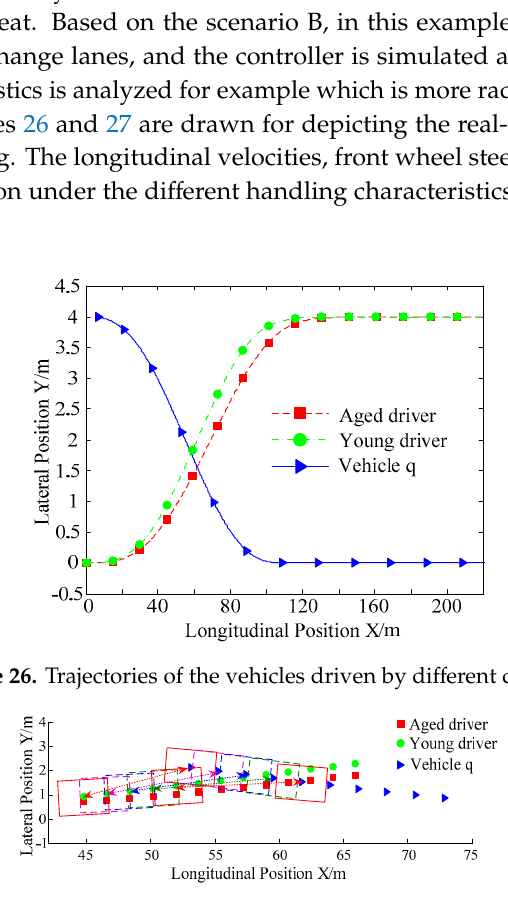
Figure 28. Longitudinal velocities of vehicle p under different velocities of vehicle q . f δ Figure 29. Front wheel angle of vehicle p under different velocities of vehicle q .